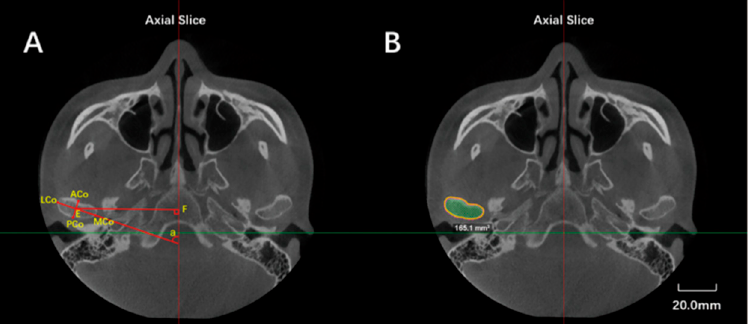
Figure 2. Measurements in the axial view of the condyle. ( A ): Anteroposterior diameter—the distance from ACo to PCo; transverse diameter—the distance from LCo to MCo; the axial angle ( ∠ α : the angle between the line connecting LCo to MCo and the midsagittal line); the axial distance (EF)—the perpendicular distance from the condylar axial center point E (the intersection of LCo-MCo and ACo-PCo) to midsagittal line. ( B ): Maximal sectional area (Smax)—the axial condylar area in this axial slice. (ACo: Most anterior point of the condyle; PCo: Most posterior point of the condyle on axial plane; LCo: Most lateral point of the condyle; MCo: Most medial point of the condyle). Two-dimensional radiographic images were created from the 3D data using the “Build X-Ray” function. Lateral cephalometric radiographs were constructed from the left and right sides of the 3D images (Figure 3). The measurement parameters of the sagittal plane included the height of the condyle, the angle of the condylar neck, and the distance from the posterior point of the condyle (Pcd) to the line perpendicular to the FH plane, passing through the sella point (Pcd-FH- p (S)) (Figure 4). The measurements of condylar neck angle were performed according to the study by Soon-Jung H et al. [15].